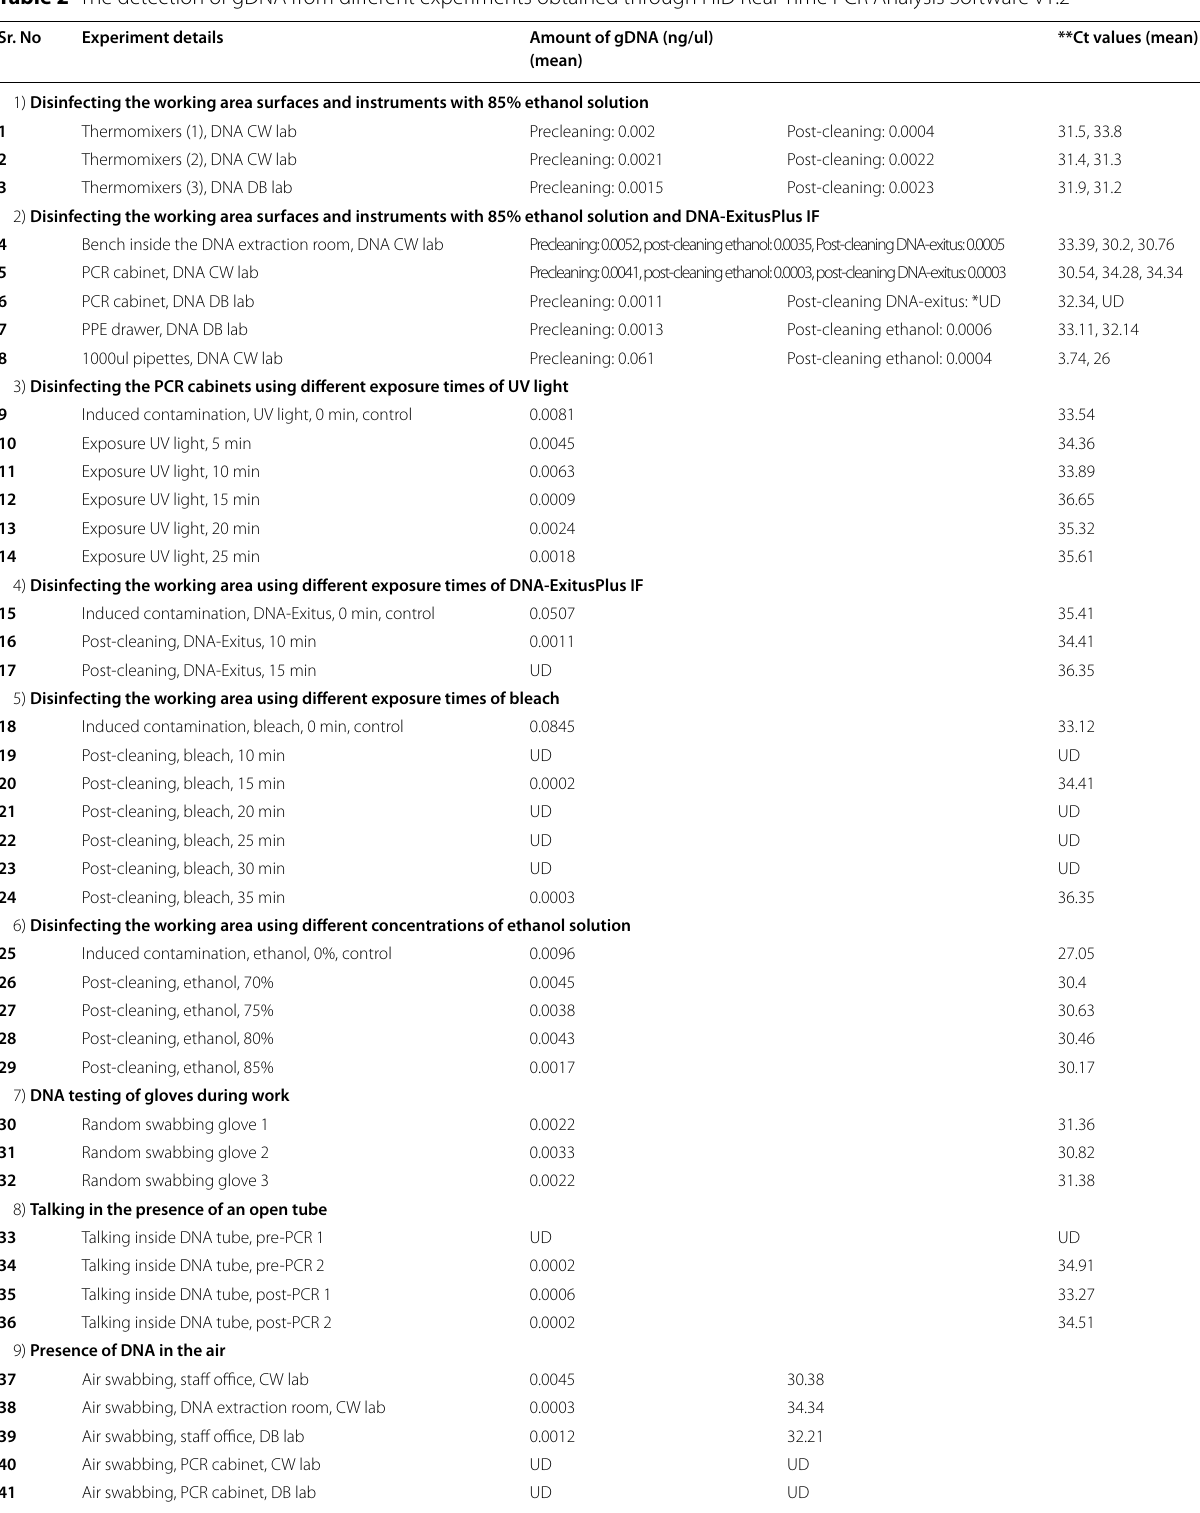
Table 2 The detection of gDNA from different experiments obtained through HID Real‑Time PCR Analysis Software v1.2 Sr.